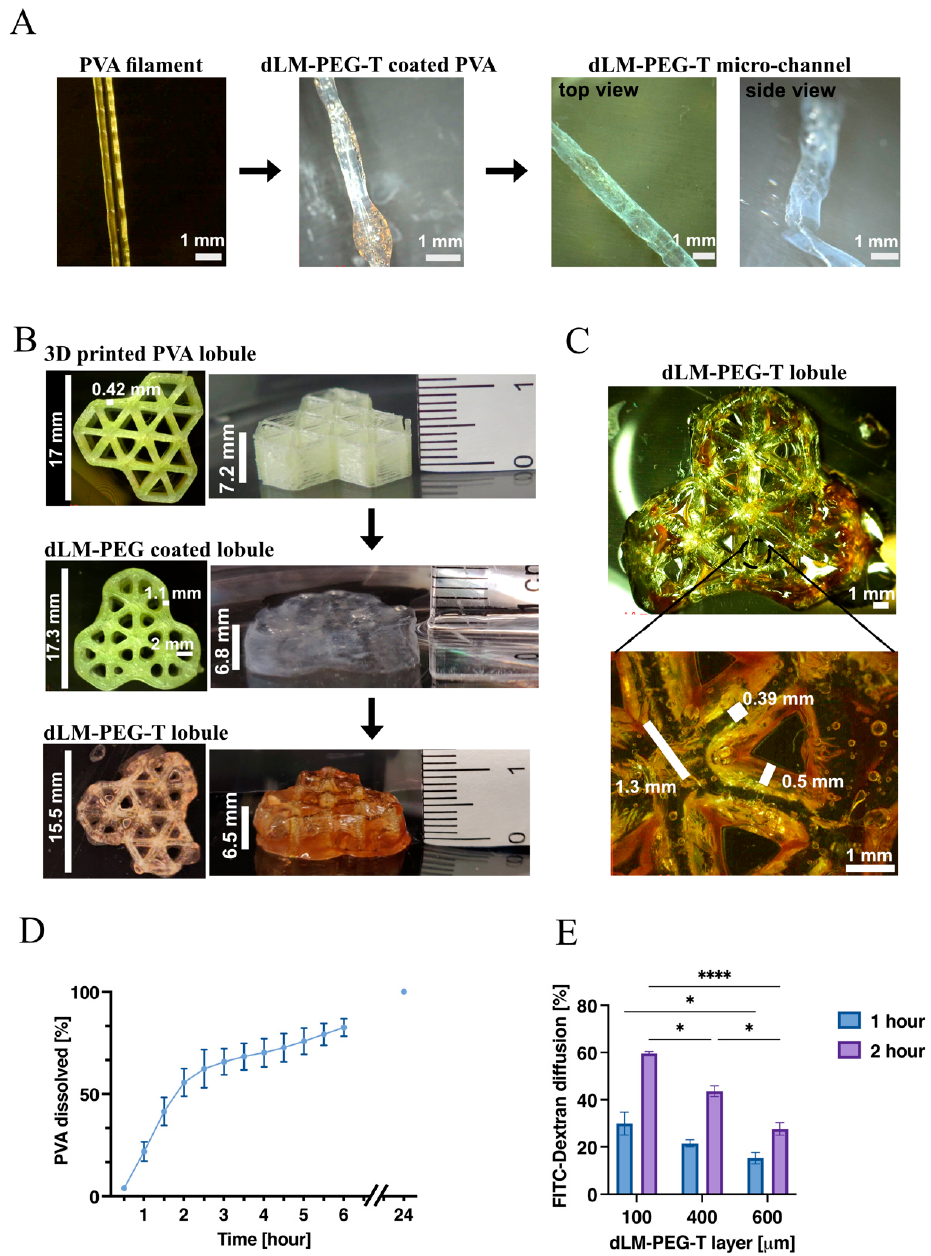
Figure 3. Development of the 3D trilobular construct with dLM-PEG-T, initiated with ( A ) the formation of a microchannel by coating the 3D-printed PVA filament. The PVA dissolved, forming a hollow tubular structure with dLM-PEG-T (scale bar 1 mm). ( B ) 3D printing of a PVA trilobular structure followed by coating it with dLM-PEG at RT and further addition of tyrosinase to form a crosslinked dLM-PEG-T trilobular construct with their respective dimensions. ( C ) Representative cross-sectional image of the dLM-PEG-T trilobular structure (top view) and its microscopic image with the line width and spacing (scale bar 1 mm). ( D ) PVA solubility kinetics ( n = 3) and ( E ) quantification of FITC-Dextran diffusion in 1 h and 2 h through the increasing thickness of dLM-PEG-T compared to the diffusion through an empty Transwell ( n = 3, * p < 0.05 and **** p < 0.0001). Error bars represent the standard error of the